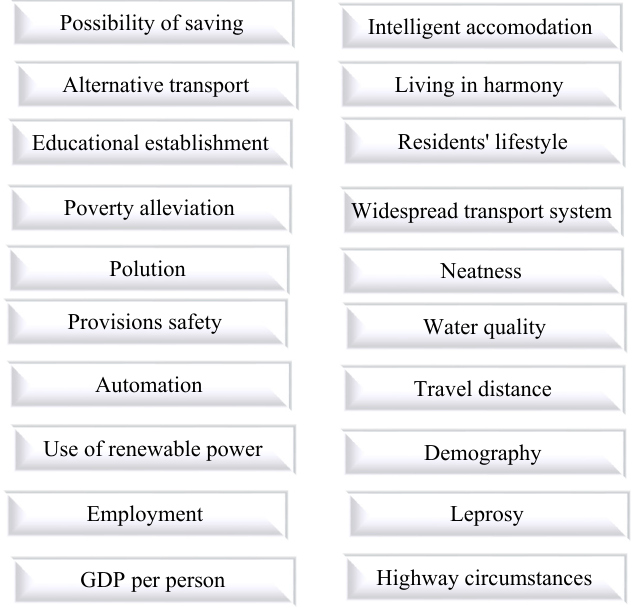
Figure 2. Smart city risk-mitigation indicators adapted via (Anand et al. 2017). The indicator values were determined by relating them to the six thematic areas; the values typically ranged from 0 to 1 depending on the degree of mitigation achieved. These